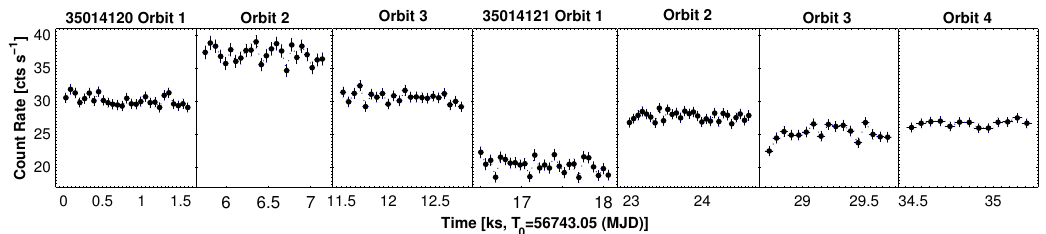
Figure 3. The 0.3–10 keV variability of Mrk421 observed with Swift-XRT on 27 March 2014 (reproduced from Kapanadze et al.